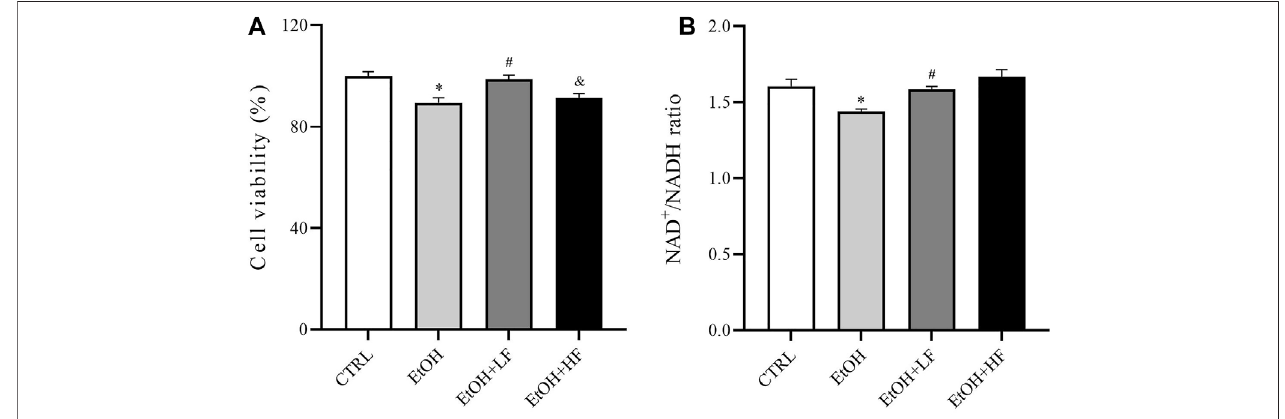
FIGURE 1 | Furfural reversed changes induced by ethanol in HepG2 cells treated with ethanol for 4 days. (A) Cell viability test with cell counting kit-8 (CCK-8). (B) The ratio of NAD + to NADH. * p < 0.05, compared with the CTRL group; # p < 0.05, compared with the EtOH group; & p < 0.05, compared with the EtOH + LF group. Abbreviations: NAD, nicotinamide adenine dinucleotide.